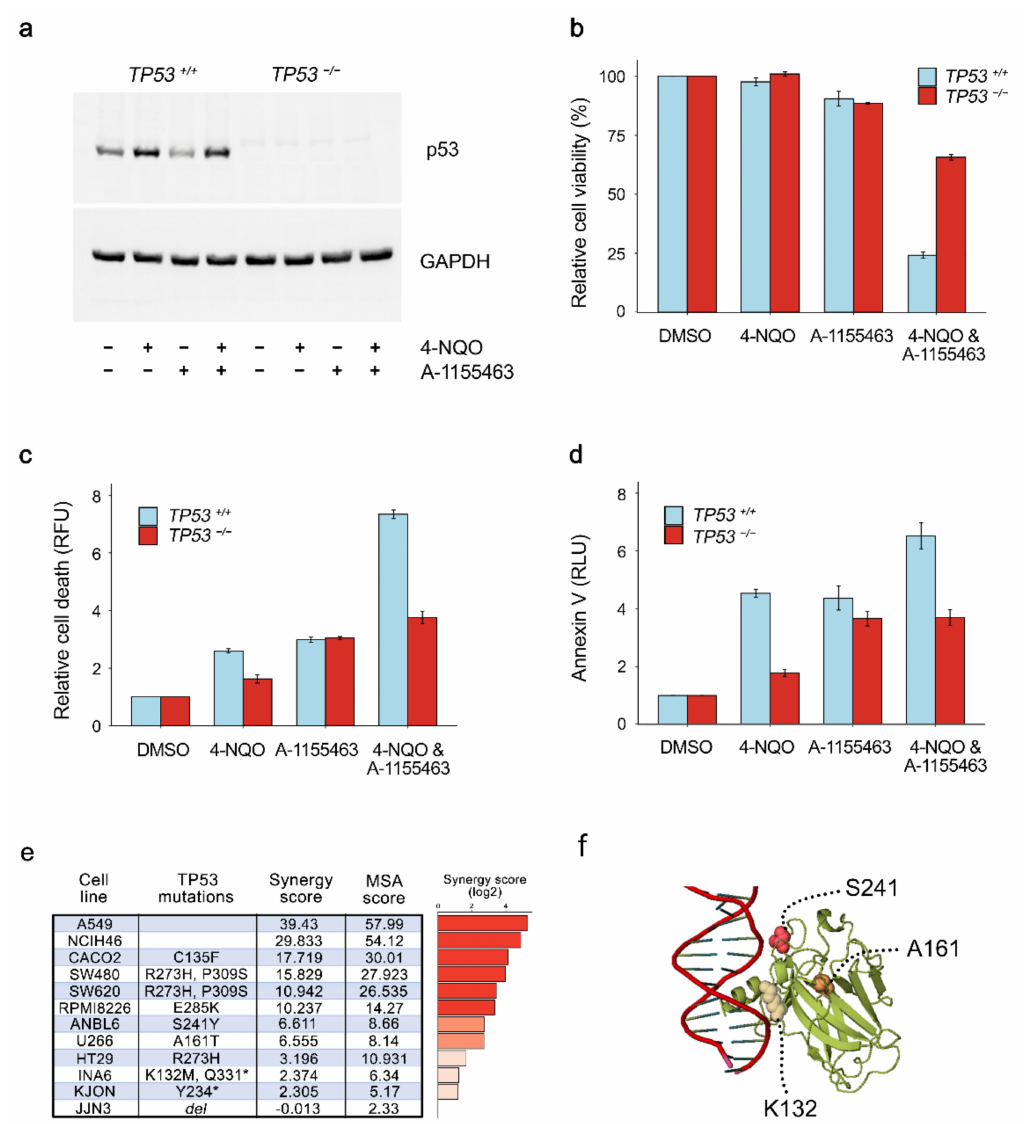
Figure 5. p53 is required for A-1155463-4NQO synergy. ( a ) HCT116 TP53 − / − and TP53 +/+ cells were treated with 1 µ M 4NQO, 1 µ M A-1155463 or their combination. Control cells were treated with 0.1% DMSO. 2 h after treatment p53 and GAPDH were analyzed using western blotting of whole-cell extracts. ( b ) Cells were treated as for (a). Cell viability was measured by the CTG assay. Mean ± SD, n = 3. ( c ) Cells were treated as for (a). Cell death was measured by the CTxG assay. Mean ± SD, n = 3. RFU—relative fluorescence units. ( d ) Cells were treated as for (a). Apoptosis was measured by the Annexin V assay. Mean ± SD, n = 3. RLU—relative luminescence units. ( e ) Table showing p53 status (according to https: // web.expasy.org / cellosaurus / ) and sensitivity scores of A-1155463-4NQO combination for several cancer cell lines. MSA score—most synergistic area score. *-truncated version. ( f ) Ribbon representation of the p53-DNA complex focusing on residues at position 132, 161, and 241, which are mutated in some cell lines from (e) (PDB code 1TUP). These residues are shown in